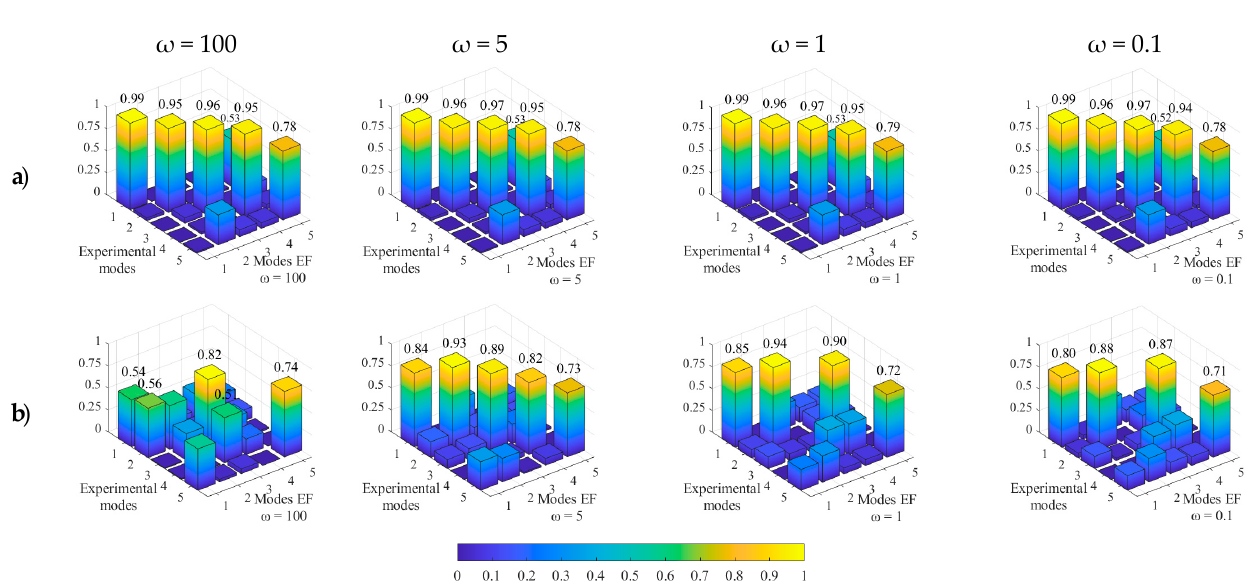
Figure 22. MAC matrixes varying the ω value from 100 to 0.1: ( a ) Pizzoli’s town hall; ( b ) former Fabriano courthouse.